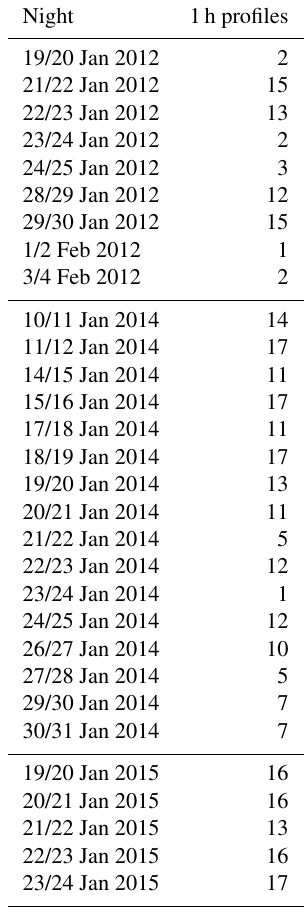
Table 1. List of lidar observations taken into account in this